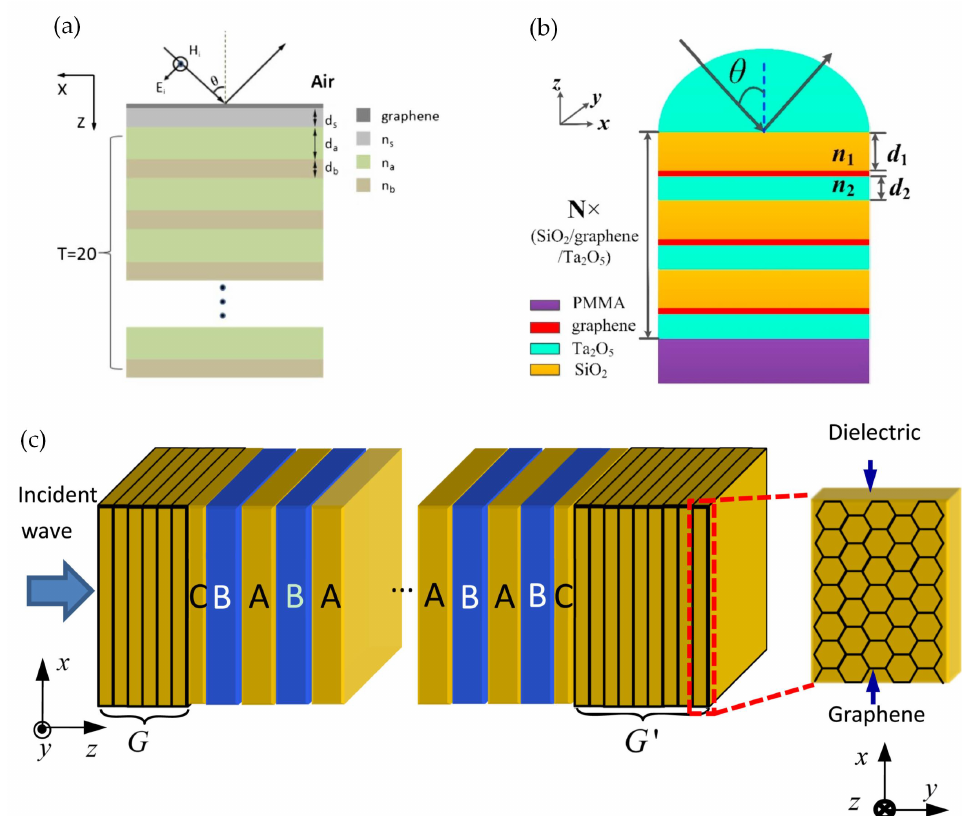
Figure 5. ( a ) schematic of THz absorber with graphene on the top and periodically stacked dielectric layers with refractive indexes n s , n a and n b respectively, reprinted with permission from Ref. [74]; ( b ) schematic of electromagnetic (EM) absorber operating at visible and near-infrared frequencies with periodically stacked SiO 2 /graphene/Ta 2 O 5 layers on poly (methyl methacrylate) (PMMA), reprinted with permission from Ref. [77]; ( c ) schematic of THz absorber with GC ( BA ) N ( AB ) N CG (cid:48) , where N is the number of layers, G and G (cid:48) consist of stacked graphene/dielectric layers and A, B, C are dielectrics, reprinted with permission from Ref.